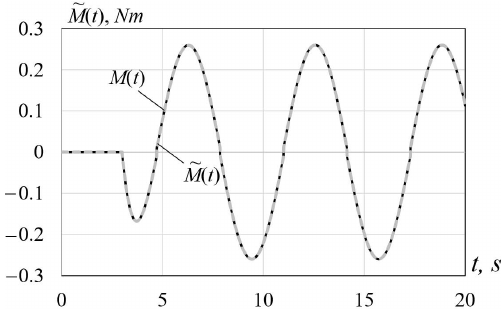
Figure 2. Behavior of the functions M ( t ) and ˜ M ( t ) .